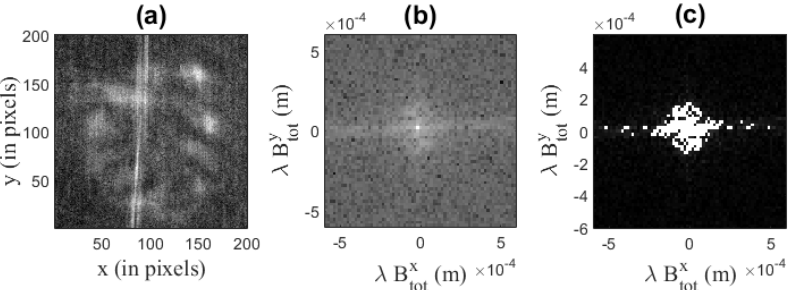
Figure 12. Section of the interferometric image of particle 4 (in cyan in Figure 7) that will be 2D Fourier-transformed ( a ), the log of its 2D Fourier transform ( b ), and its binarization ( c ).